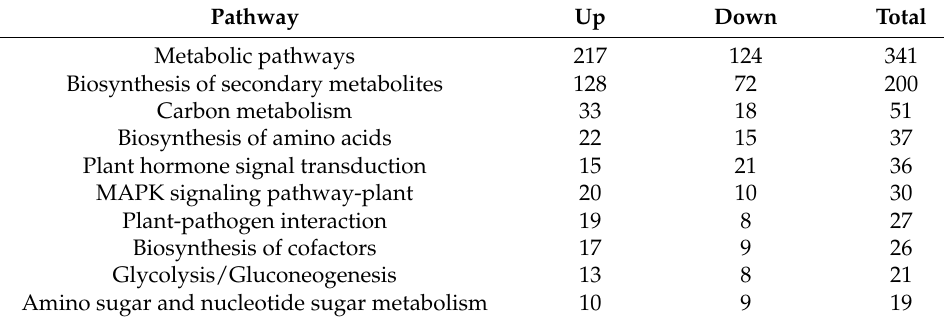
Table 4. Top 10 pathways enriched in the “MgO7d vs. MgO7d + FOL1h” group.